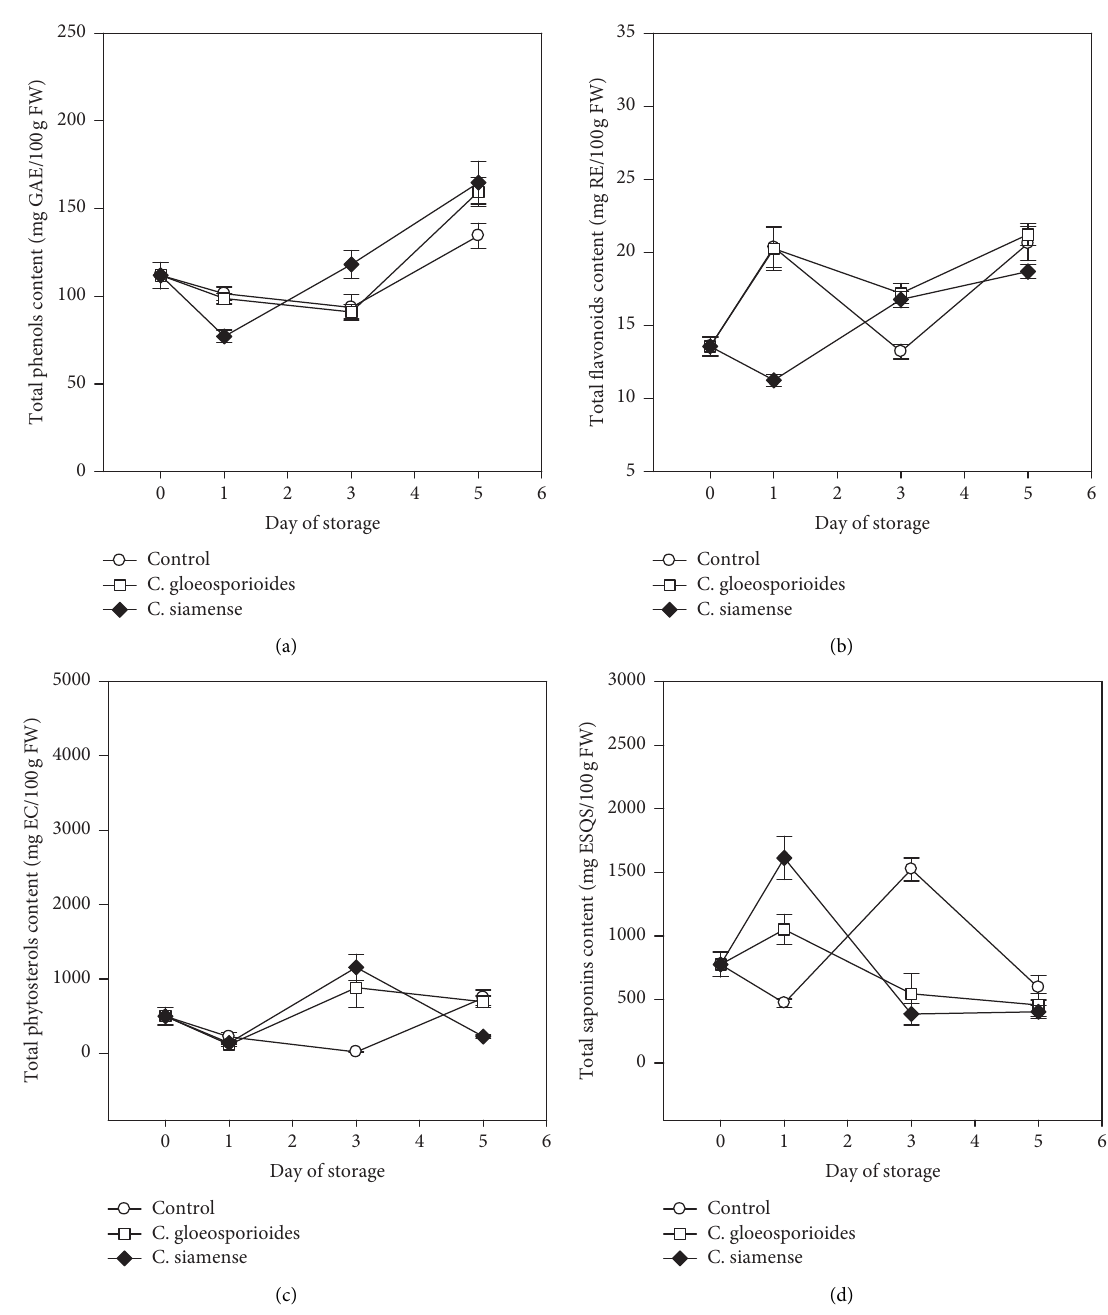
Figure 3: Total soluble phenols (a), total flavonoids (b), total phytosterols (c), and total saponins (d) content in soursop fruits with three different treatments. Control (C), C. gloeosporioides , and C. siamense